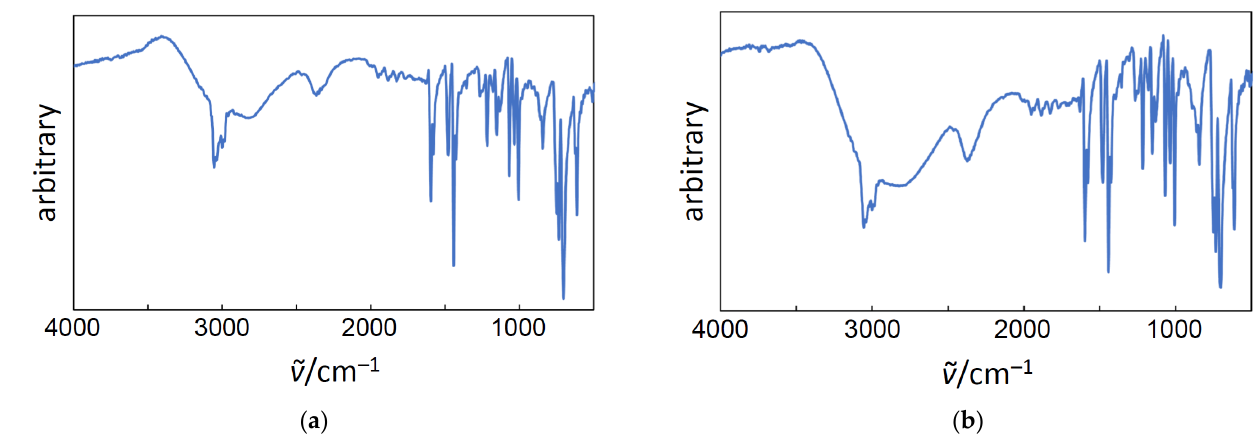
Figure 2. IR spectra of 1 and 2 : ( a ) [Ni(H 2 O) 2 (py) 4 ][BPh 4 ] 2 ·4py ( 1 ); ( b ) [Co(H 2 O) 2 (py) 4 ][BPh 4 ] 2 ·4py ( 2